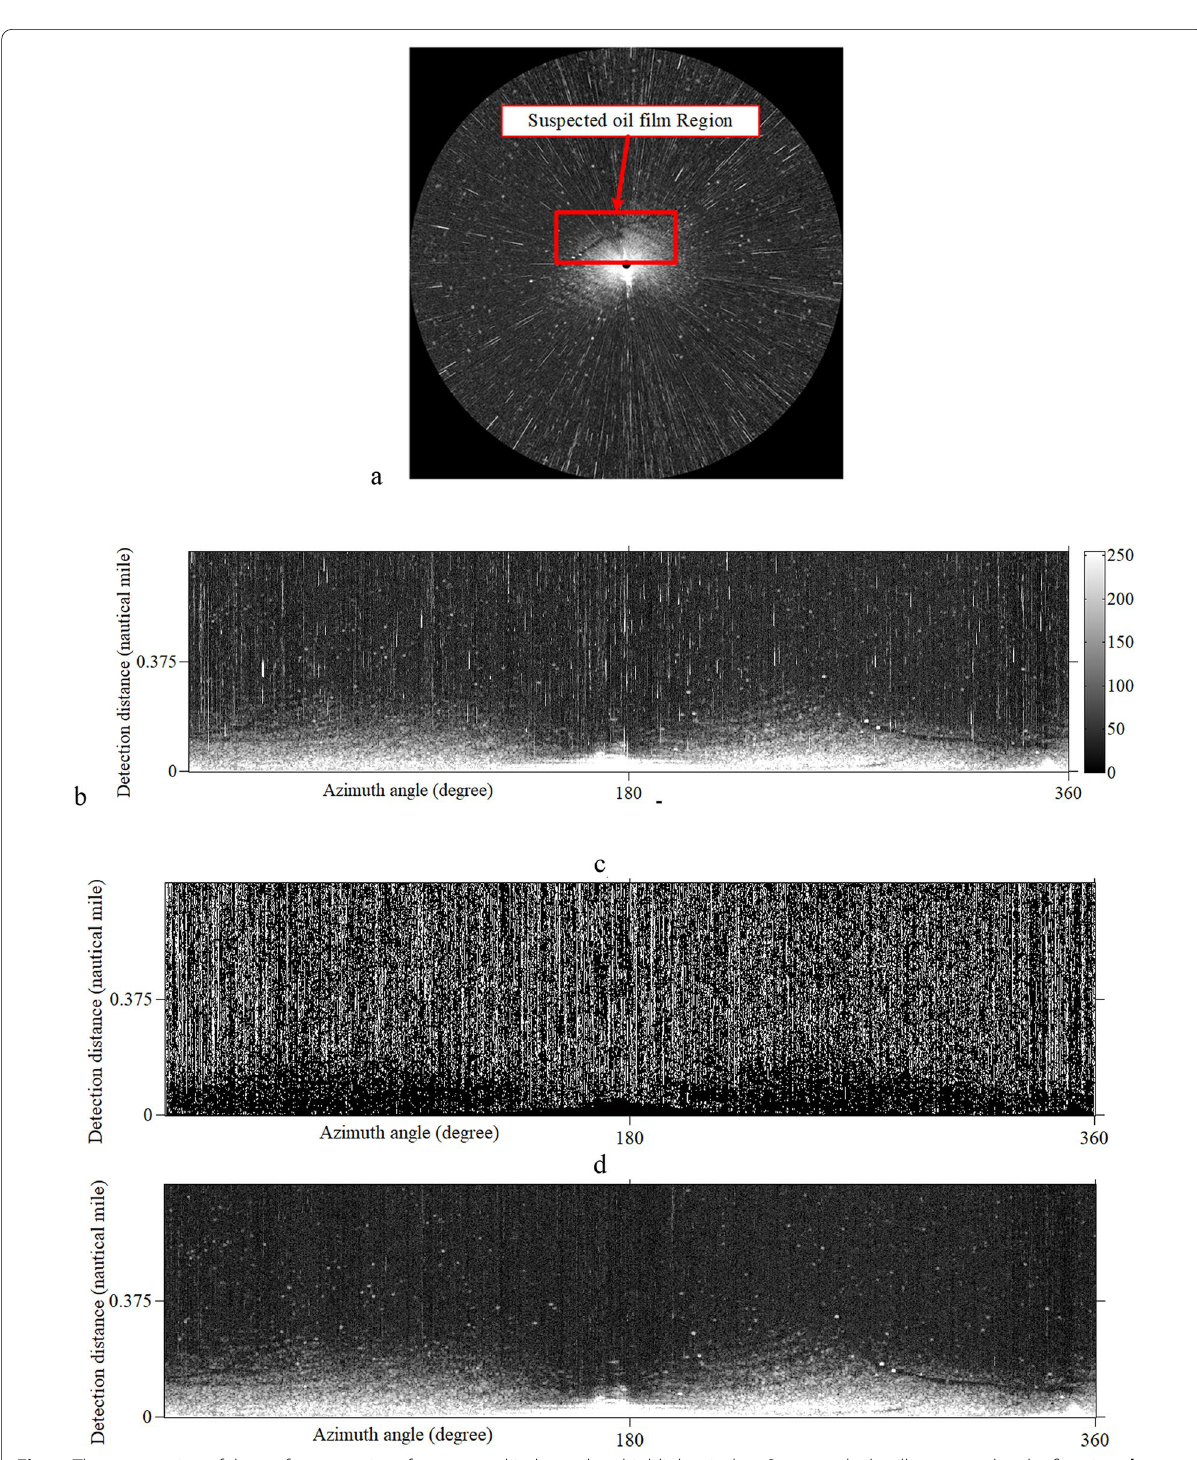
Fig. 5 The suppression of the co-frequency interferences and independent highlight pixels. a Suspected oil spills appeared at the first time; b Cartesian coordinate system transformation; c improved Sobel operator convolution and Otsu threshold segmentation, d linear interpolation